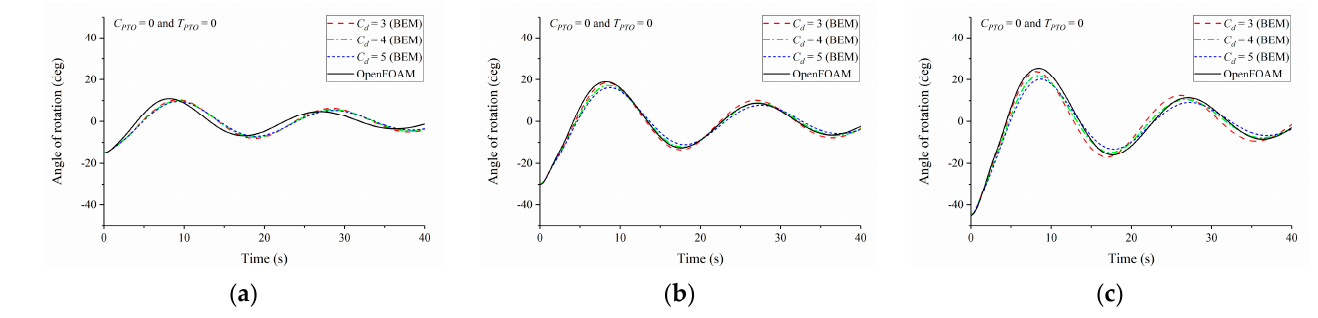
Figure 13. The comparison of free decay between BEM and CFD for a flap without a PTO system ( C PTO = 0 and T PTO = 0) and with different initial angles: ( a ) 15 deg.; ( b ) 30 deg.; ( c ) 45